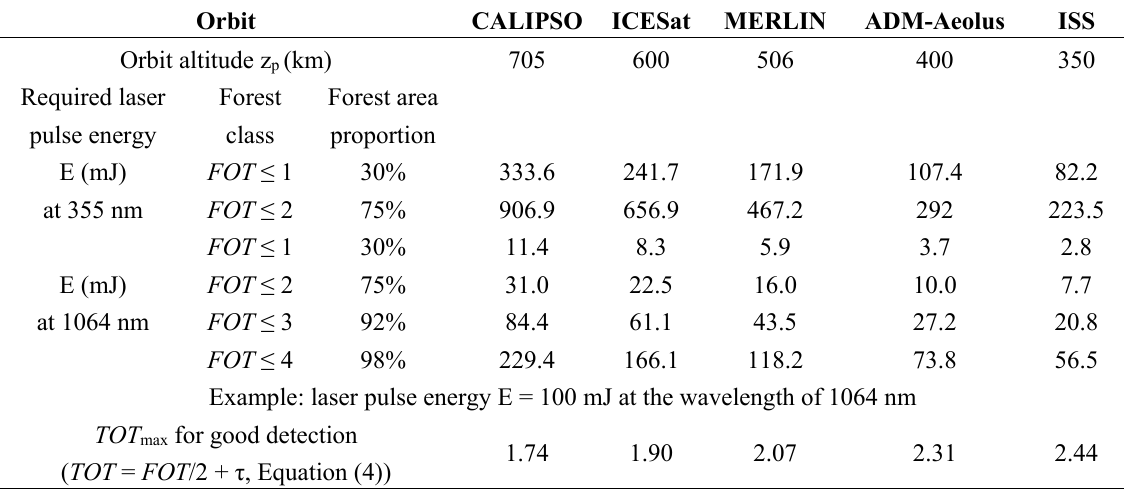
Table 6. Required energy E in 355 nm or 1064 nm to get a good detection (GE SNR ~10) under ideal atmospheric conditions for 4 forest classes. Each class represents forests with forest optical thicknesses ( FOT ) less than a certain value (1, 2, 3, 4). The corresponding area proportion of each forest class among the total forest area is also given. An example of maximum value of the total optical thickness ( TOT max ) at which the detection is still good, for a lidar system emitting 100 mJ at 1064 nm, is also given. The instrumental parameters used are given in Table